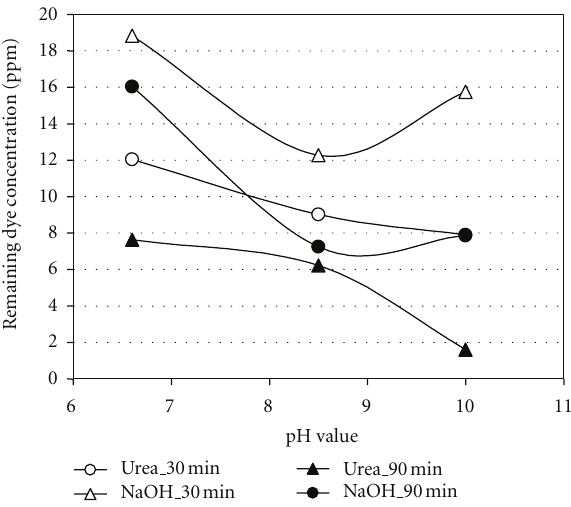
Figure 8: The pH influence on R 6G decolorizing after 30 and 90 minutes of photoreaction (0.3g/L catalyst, 30 ppm pf dye initially).